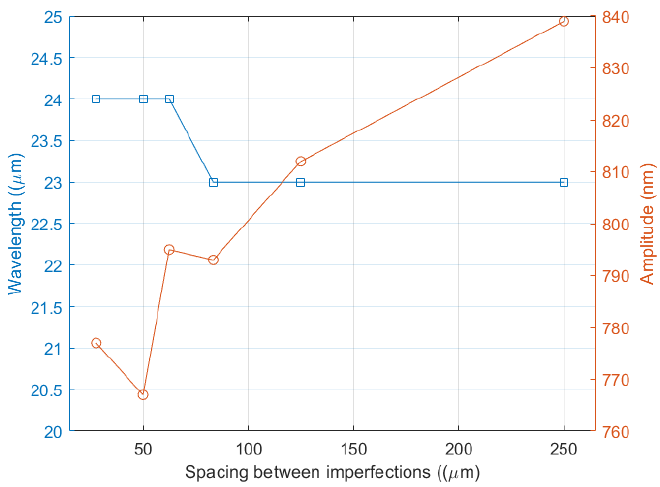
Figure 3. Wrinkling wavelength and amplitude vs. spacing between imperfections.